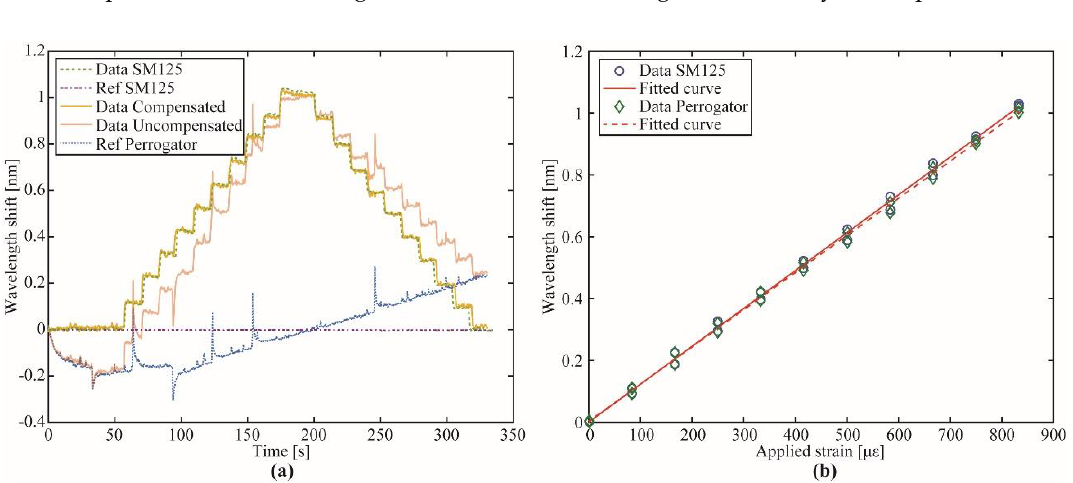
Figure 8. Strain characterization. ( a ) Compensation of temporal FFP-TF drift; ( b ) wavelength shift as a function of applied strain for both the SM125 interrogator and the proposed interrogator.